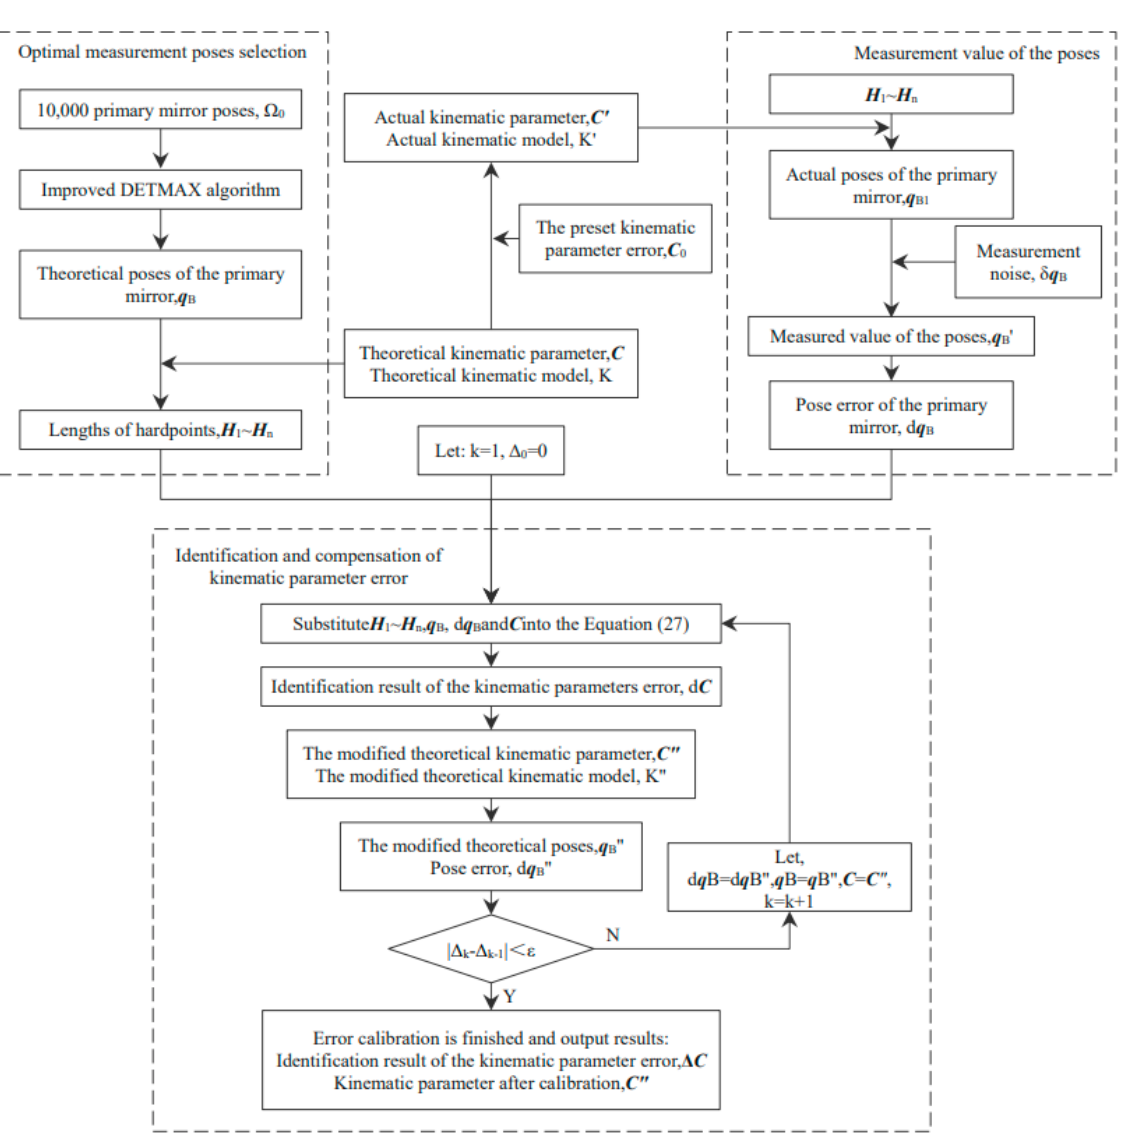
Figure 4. Process diagram of numerical simulation of kinematic calibration for six-hardpoint posi- tioning mechanisms.